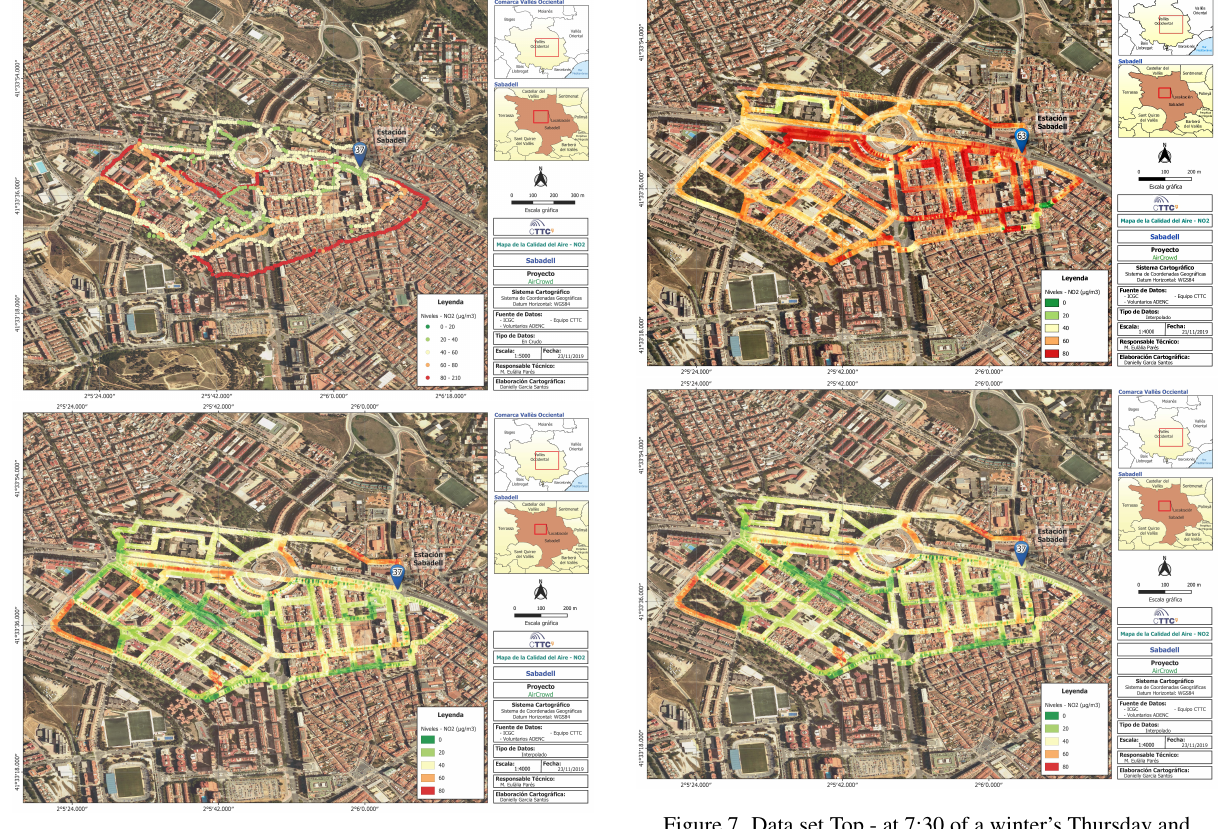
Figure 6. Data set Top.- Before and Bottom.- after calibration